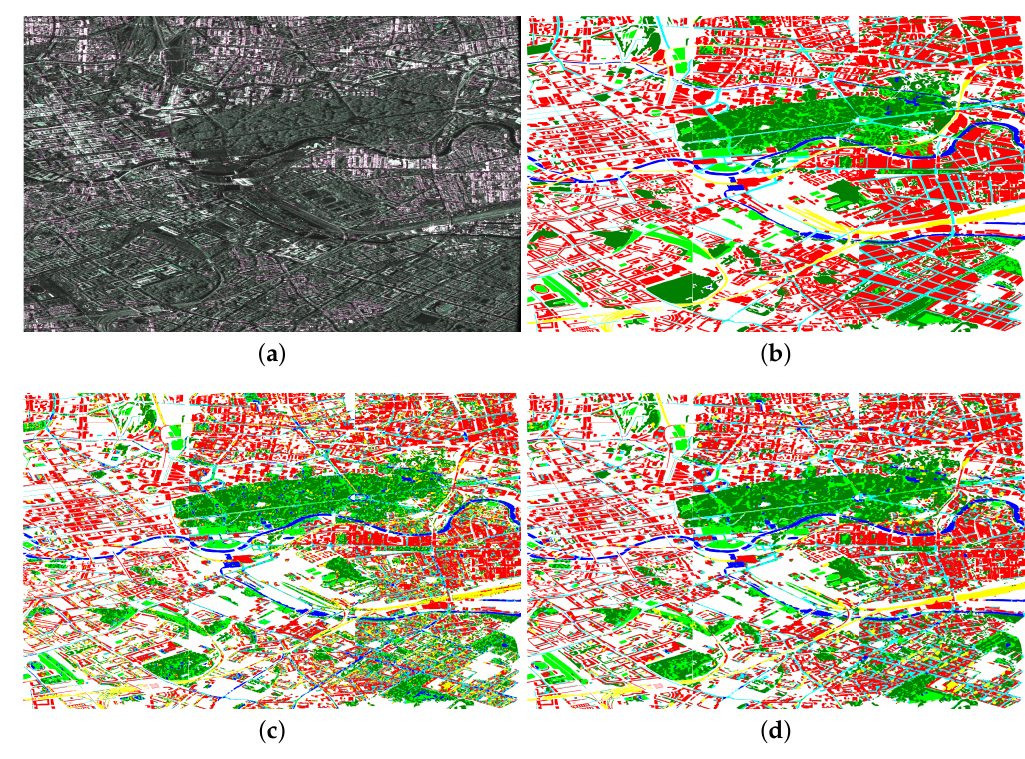
Figure 6. Input data and results of the Berlin dataset. ( a ) Image Data (TerraSAR-X, DLR, X-Band); ( b ) Reference Data: Building (red), Road (cyan), Railway (yellow), Forest (dark green), Lawn (light green), Water (blue), unlabelled pixels in white; ( c ) Classification map obtained by the RF at Level 0; ( d ) Classification map obtained by the RF at Level 9.